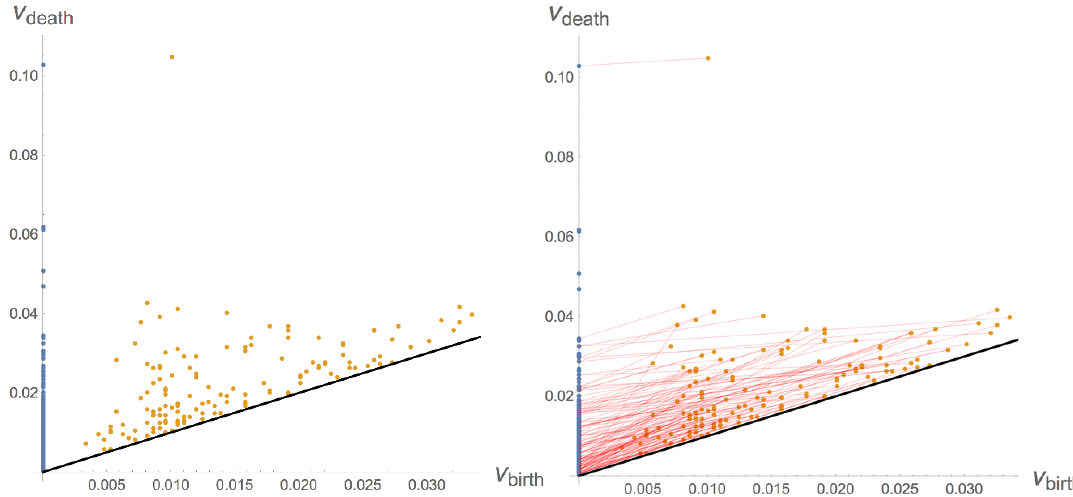
Figure 8 . Left: persistence diagram for rigid Calabi-Yau (cid:13)ux vacua projected onto axiodilaton with L max = 150, using a lazy witness complex with 700 landmark points. The (cid:12)ltration has 1,140,182 simplices. The orange points represent 1-cycles and the blue points represent